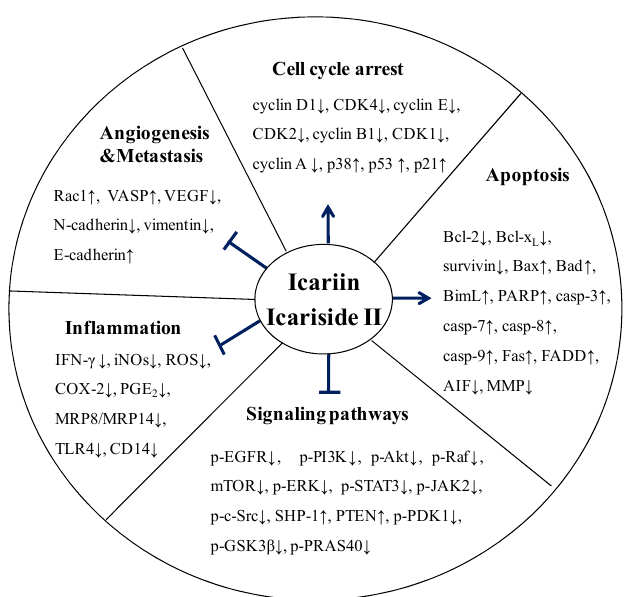
Figure 2. Overview of the anti-cancer effects of icariin and icariside II. Icariin and icariside II stimulate the cell cycle arrest via upregulation of p38, p53, and p21. Icariin and icariside II are involved in the induction of apoptosis and inhibit tumor angiogenesis and metastasis via suppression of multiple signaling pathways. They also have anti-inflammatory effects via downregulation of several factors, such as IFN- γ , iNOs, and COX-2, ( ← activation; ⊥ inhibition; ↑ , up-regulation; ↓ , down ‐ regulation).